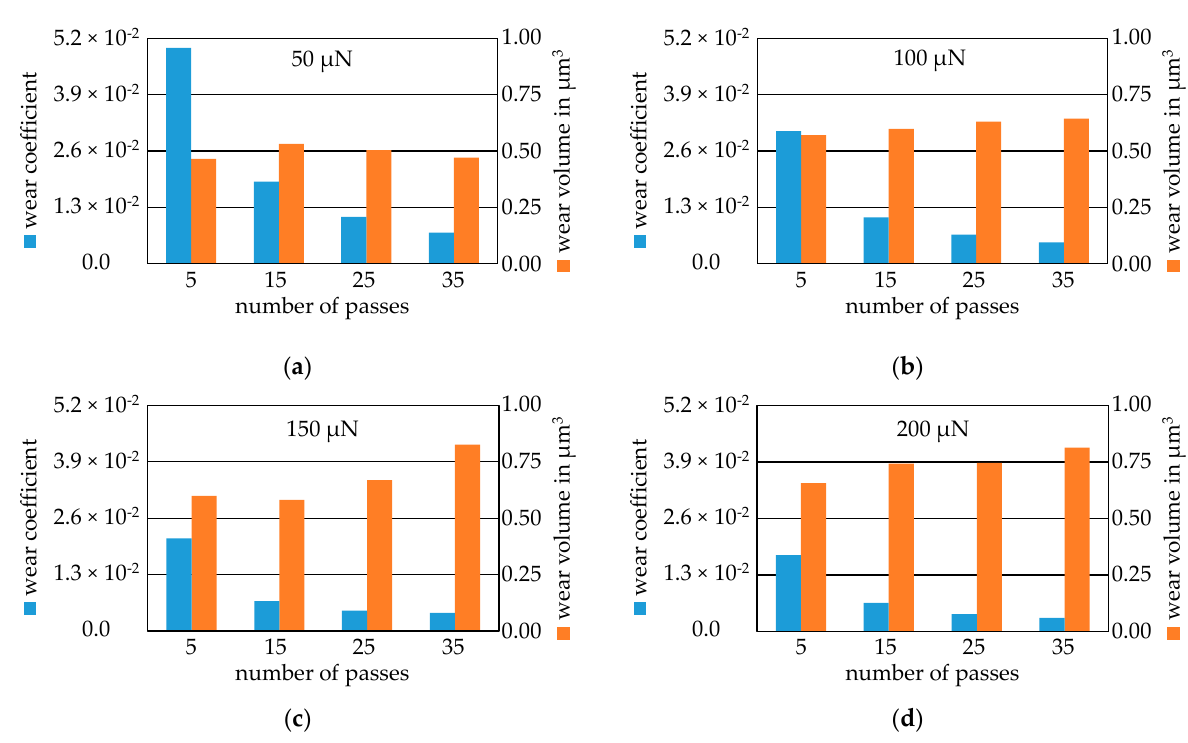
Figure A4. Development of the average wear volumes and average coefficients of wear over the number of passes of the Mo-coating: ( a ) 50 µ N; ( b ) 100 µ N; ( c ) 150 µ N; ( d ) 200 µ N.